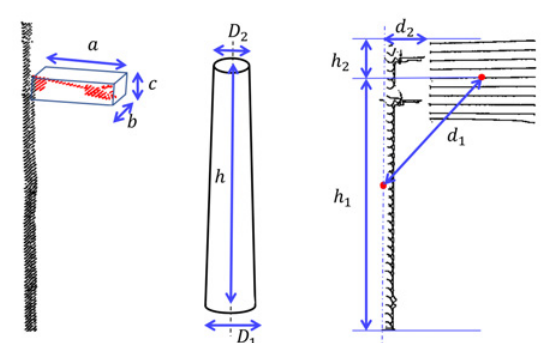
Figure 9. Feature values of poles and target